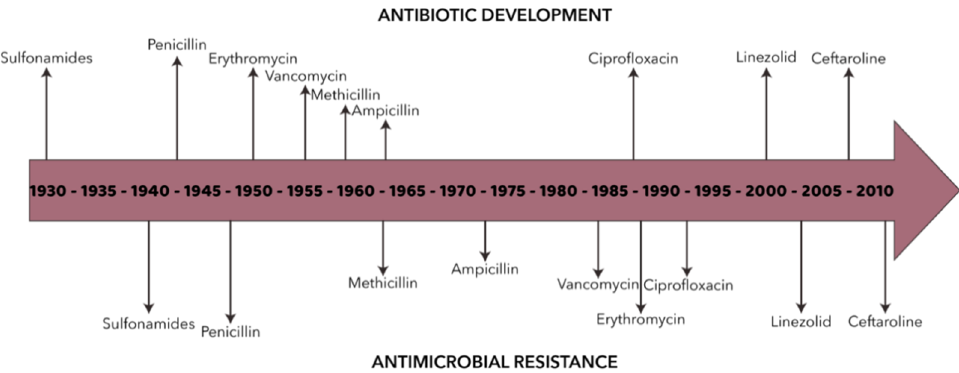
Figure 2. Schematic representation of antibiotic development and antimicrobial resistance appearance over time. Adapted from an open-access source [60,61].